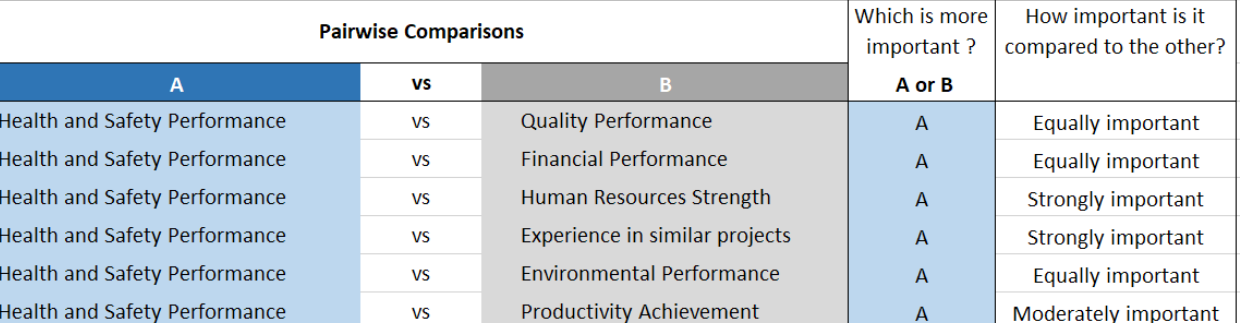
Figure 2. Extract from pairwise comparisons template.